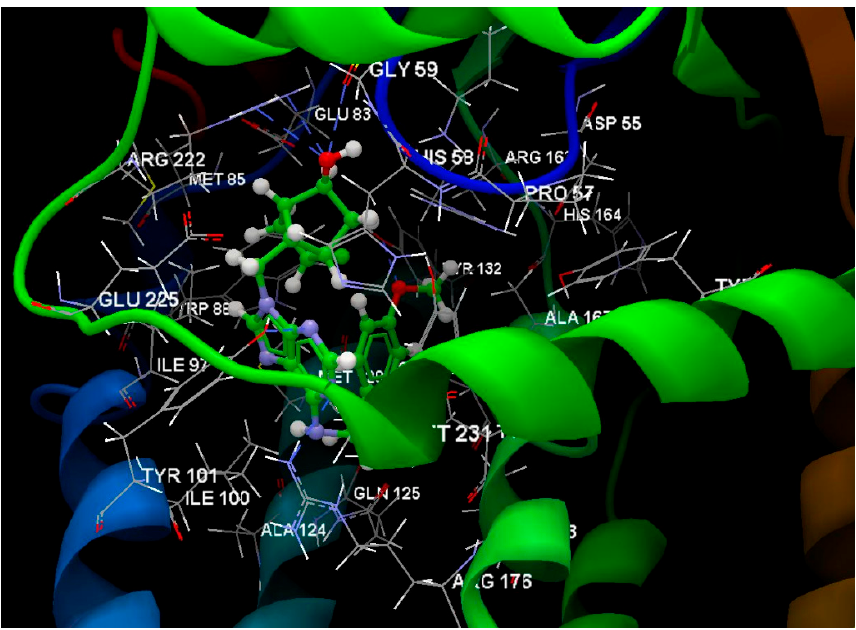
Figure 5. Docking pose of the 6j ligand interacting with amino acids residues.